Question: Name the type of graph shown.
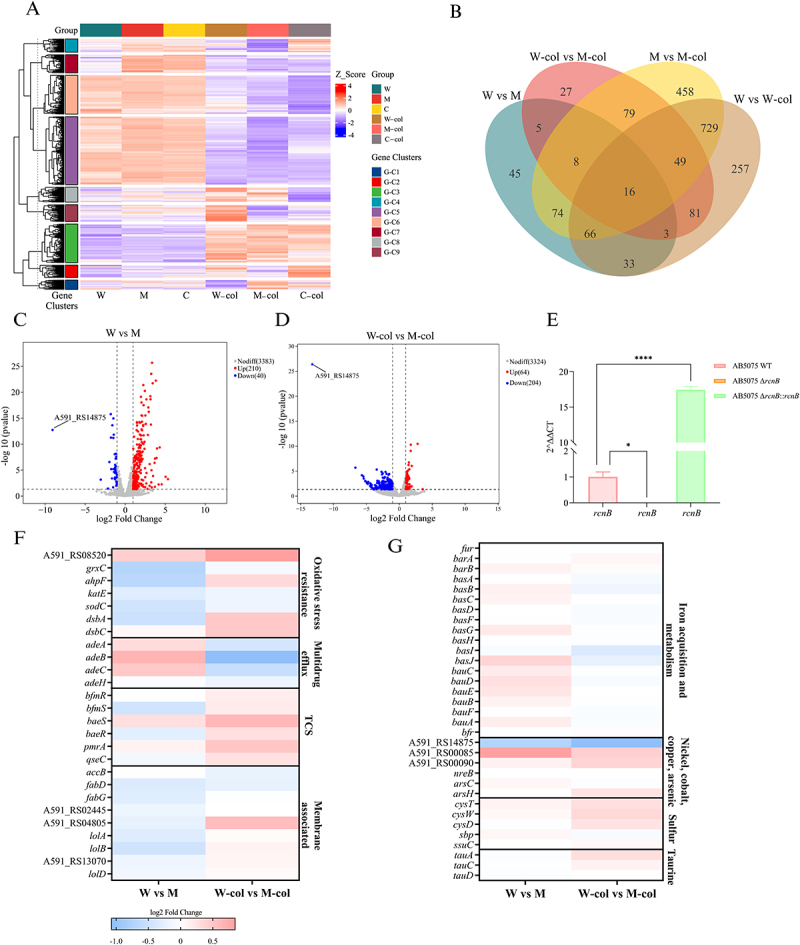
Answer: heatmap